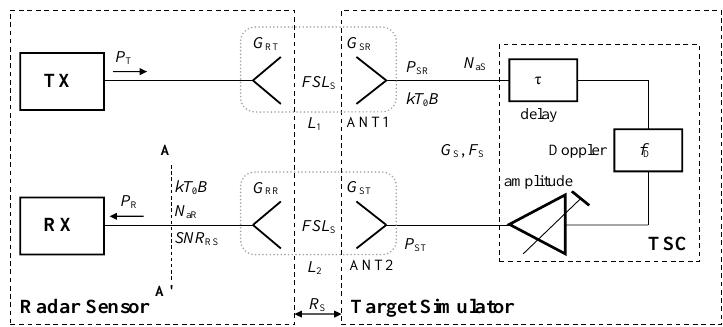
Figure 1. Block diagram with basic automotive radar (AR) sensor–target simulator (TS) relations.